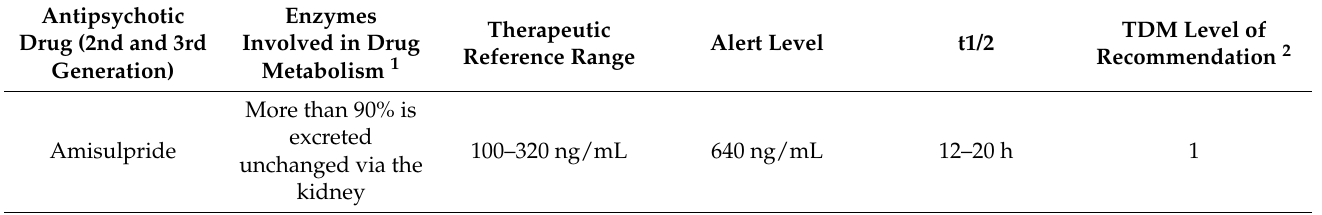
Table 1. Therapeutic drug monitoring of second- and third-generation antipsychotic drugs.